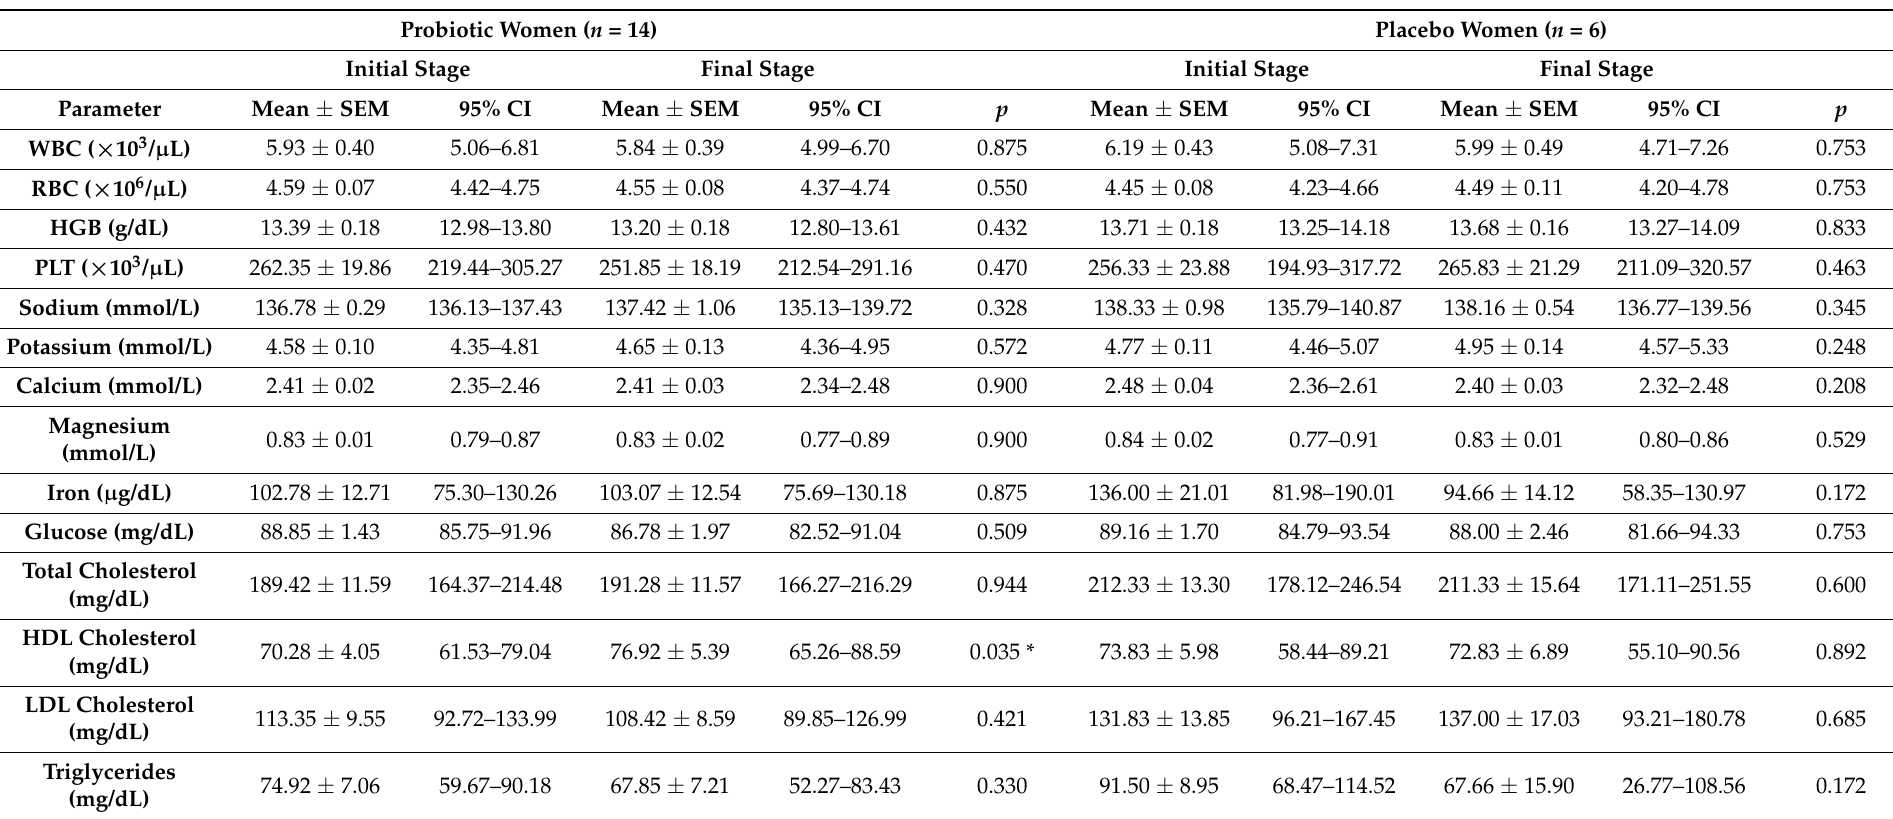
Table 1. Comparison of blood biochemical parameters in women from the probiotic and placebo groups at the initial and final stages of the study. * Statistical significance ( p < 0.05) determined between the initial and final